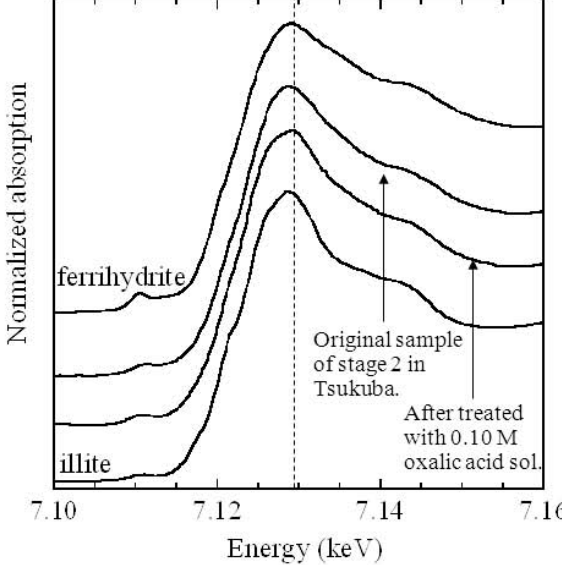
Fig. 8. Normalized Fe K-edge XANES spectra of aerosol sample collected at stage 2 in Tsukuba before and after the treatment with oxalic acid solution (0.10